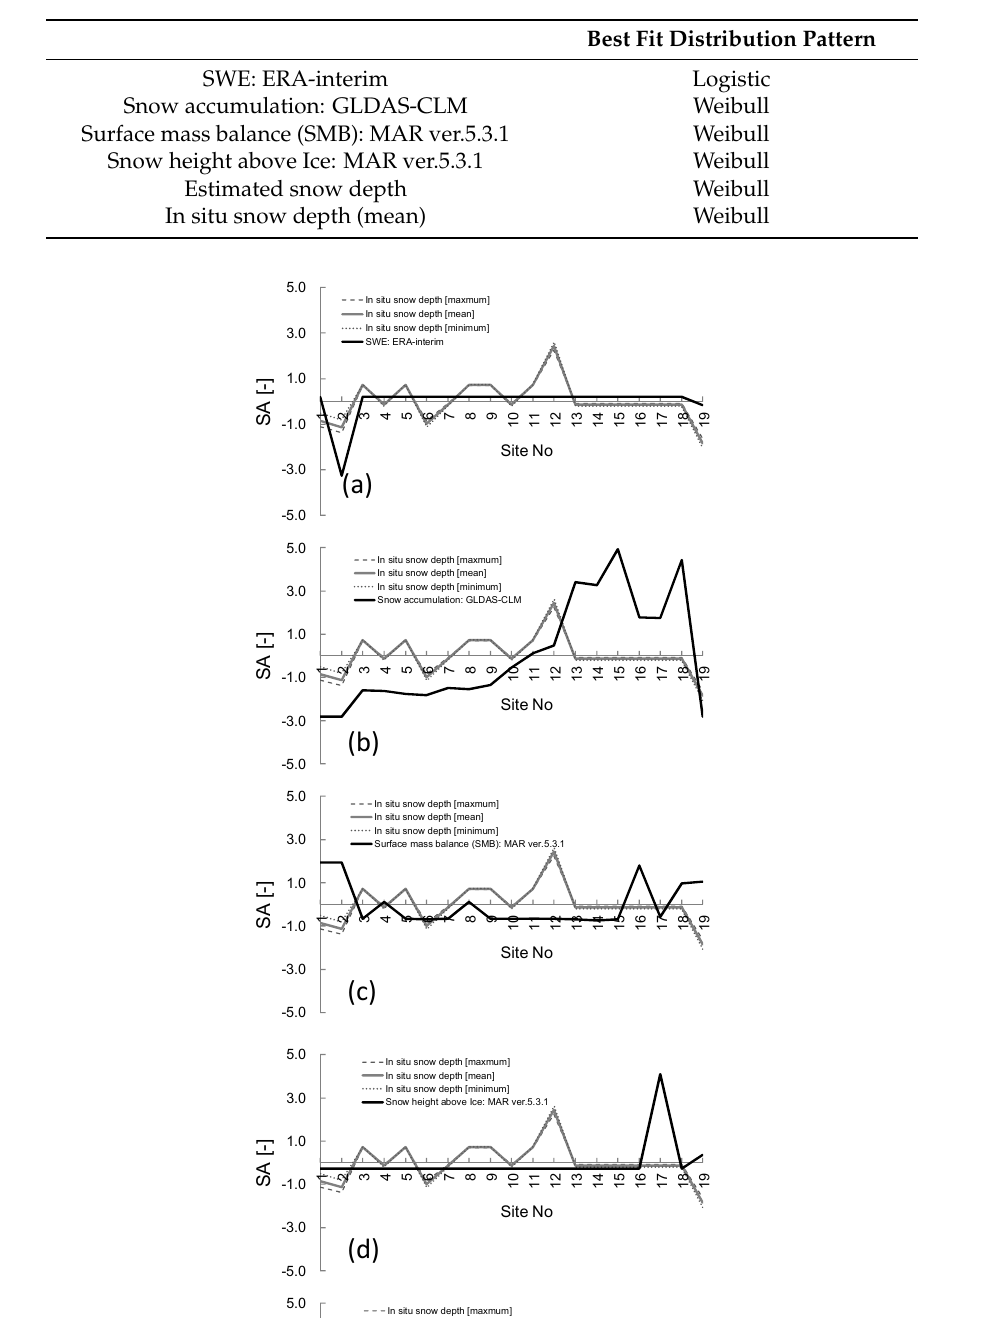
Table 5. Best fit distribution the pattern for parameters of each product.